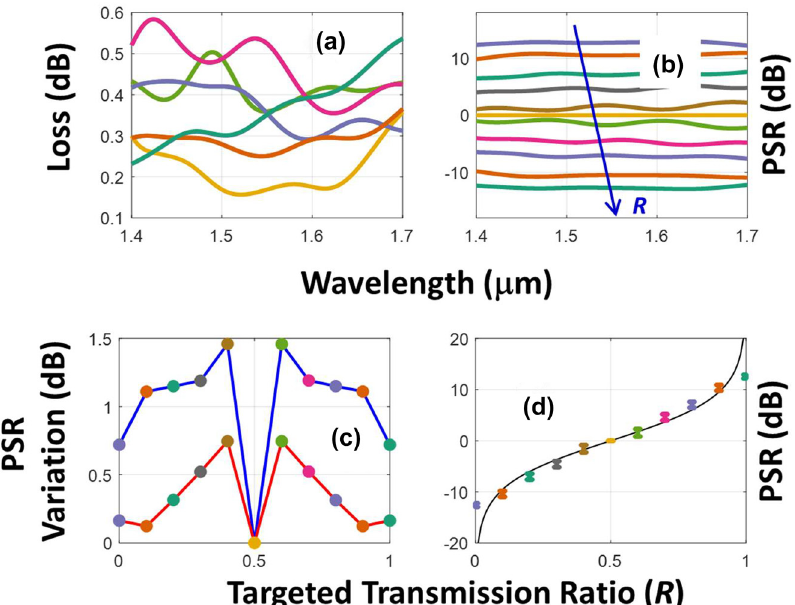
Figure 7: Wavelength response of the inverse-designed power dividers. (a) FDTD losses and (b) power splitting ratio as functions of wavelengths for various targeted transmission ratios. (c) Power splitting ratio variation across 300 nm (blue) and 100 (red) wavelength windows centered at 1550 nm. (d) Power splitting ratio variations across a 300 nm wavelength plotted on the ideal design curve. In all (a)–(d), similar color codes are used for devices with the same R . The color for each R can be identified using the respective marker colors from Figure 6(c) and